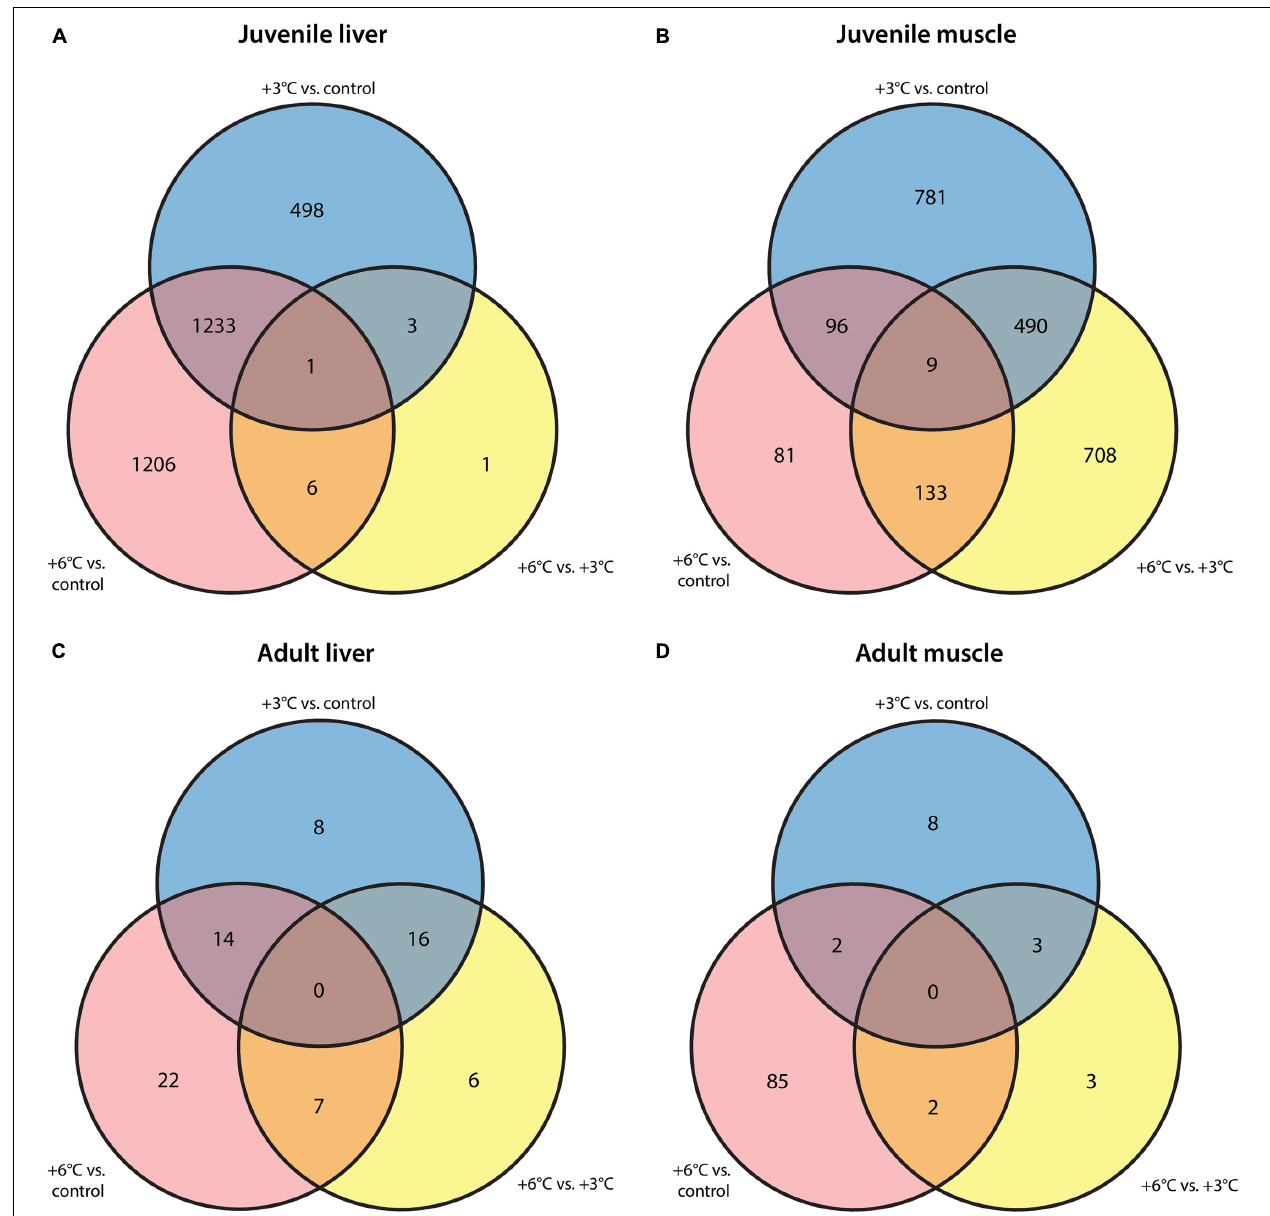
FIGURE 3 | Venn diagrams showing the number of differentially expressed genes in (A) juvenile liver, (B) juvenile muscle, (C) adult liver, and (D) adult muscle tissue, and the overlapping genes between thermal